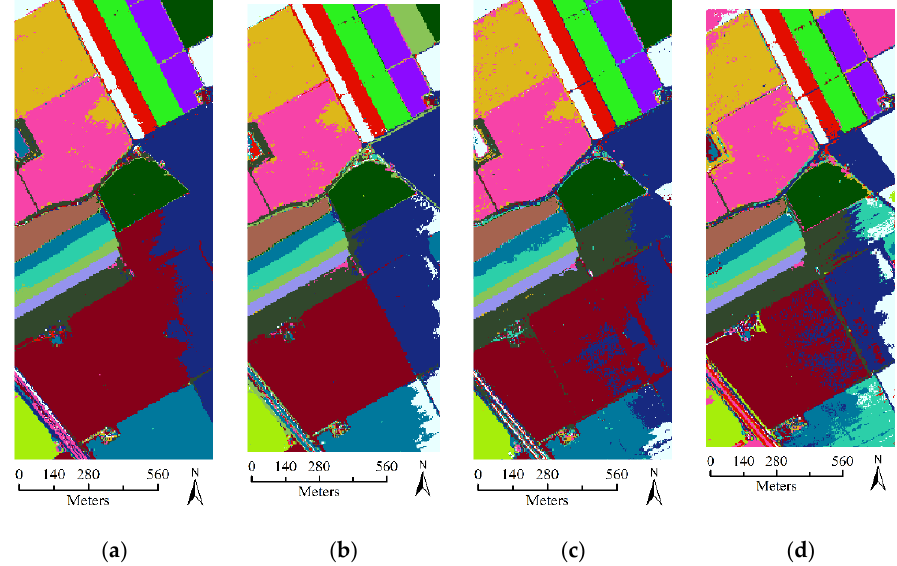
Figure 16. Classification maps obtained by using different strategies to ensure confidence for Salinas Valley dataset: ( a ) with SC and ASR (97.24%); ( b ) with SC (96.97%); ( c ) with ASR (96.38%); and, ( d ) without SC or ASR (95.51%).